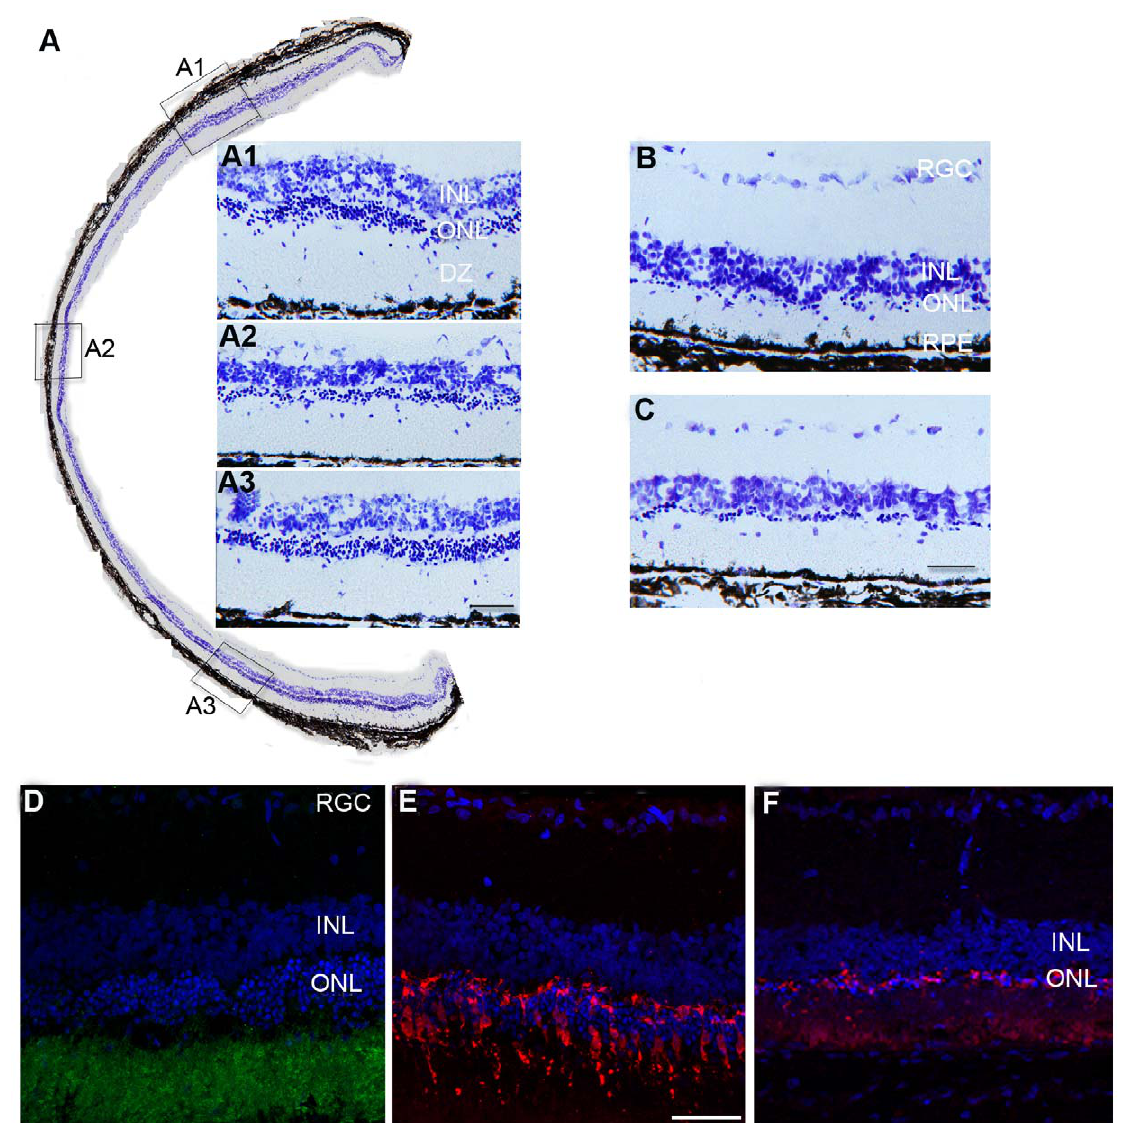
Figure 1. Rod and cone protection. A. Retinal sections stained with cresyl violet indicate substantial preservation of photoreceptors across the retina in MSC treated eyes at P90, while in control eyes (sham injected (B) and untreated (C)): only a single layer of photoreceptors remained. A1, A2 &A3: higher power images showing preservation of photoreceptors from the insets A1, A2 &A3 in A. D, E&F: confocal images showing rhodopsin (green in D) and cone arrestin (red in E) positive staining at P90 in MSC treated retina, while in sham injected retina, cone arrestin staining was dramatically reduced (F). All sections were counterstained with DAPI (blue) (scale bars equal 50 m m).